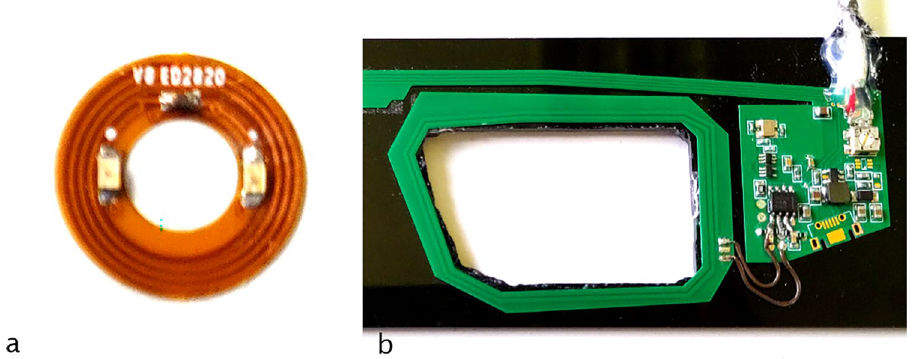
Figure 5. ( a ) the electronics encapsulated into the SCL with the coils, two VCSELs and the according capacitor, ( b ) the electronics inside the eyewear, with the primary antenna coil on the left and the transformer on the